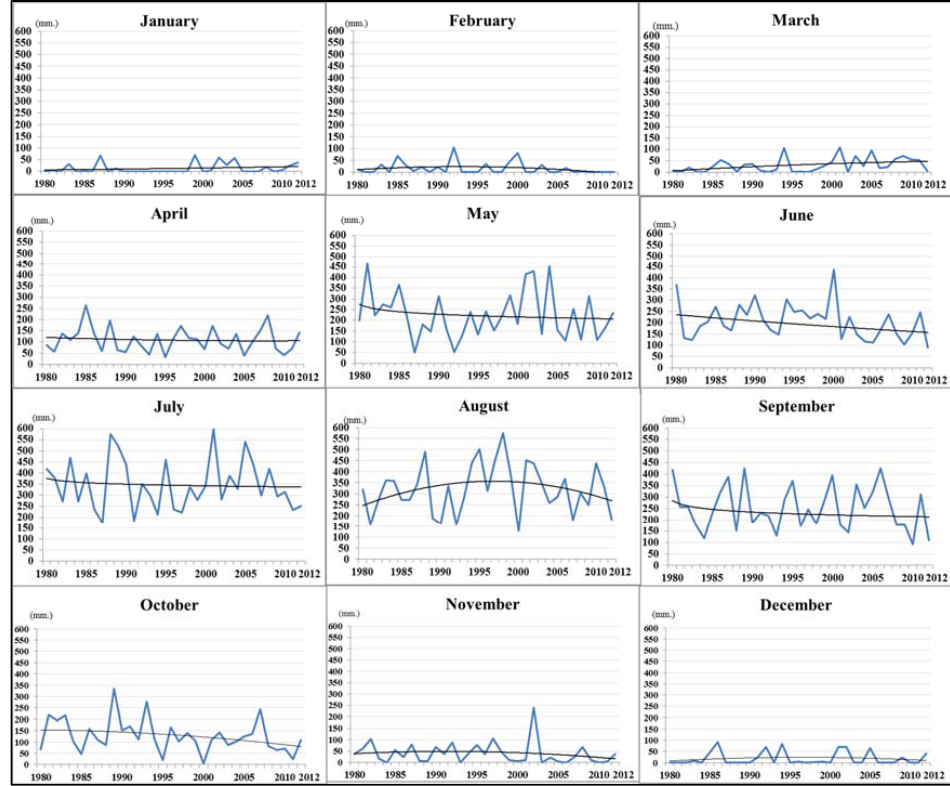
Figure 4. Monthly rainfall for 1980–2012 at Mae Chan Hill tribe Development station in Chiangrai province.